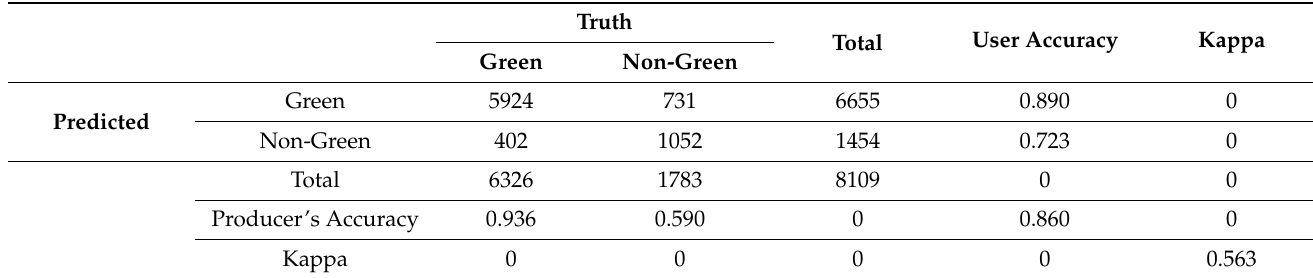
Table 3. Confusion matrix and accuracy assessment of green/non-green classification based on CCI-LC, 2015.